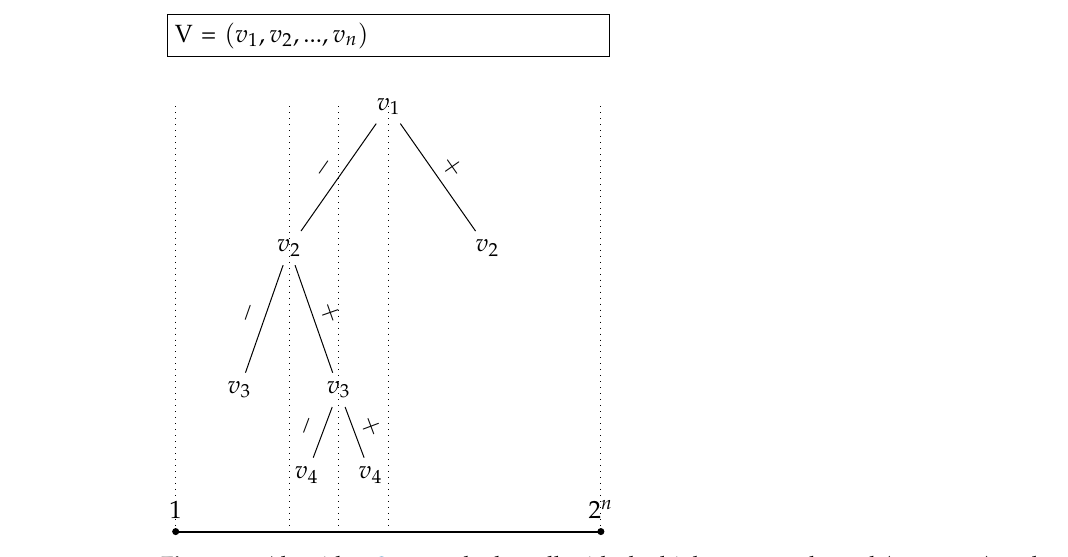
Figure 7. Algorithm 3 expands the cell with the highest upper bound ( − v 1 , + v 2 ) and evaluates the upper bounds of cells ( − v 1 , + v 2 , + v 3 ) and ( − v 1 , + v 2 , − v 3 ) (upper bounds of cells (+ v 1 ), and ( − v − v ) are 2 1 ,